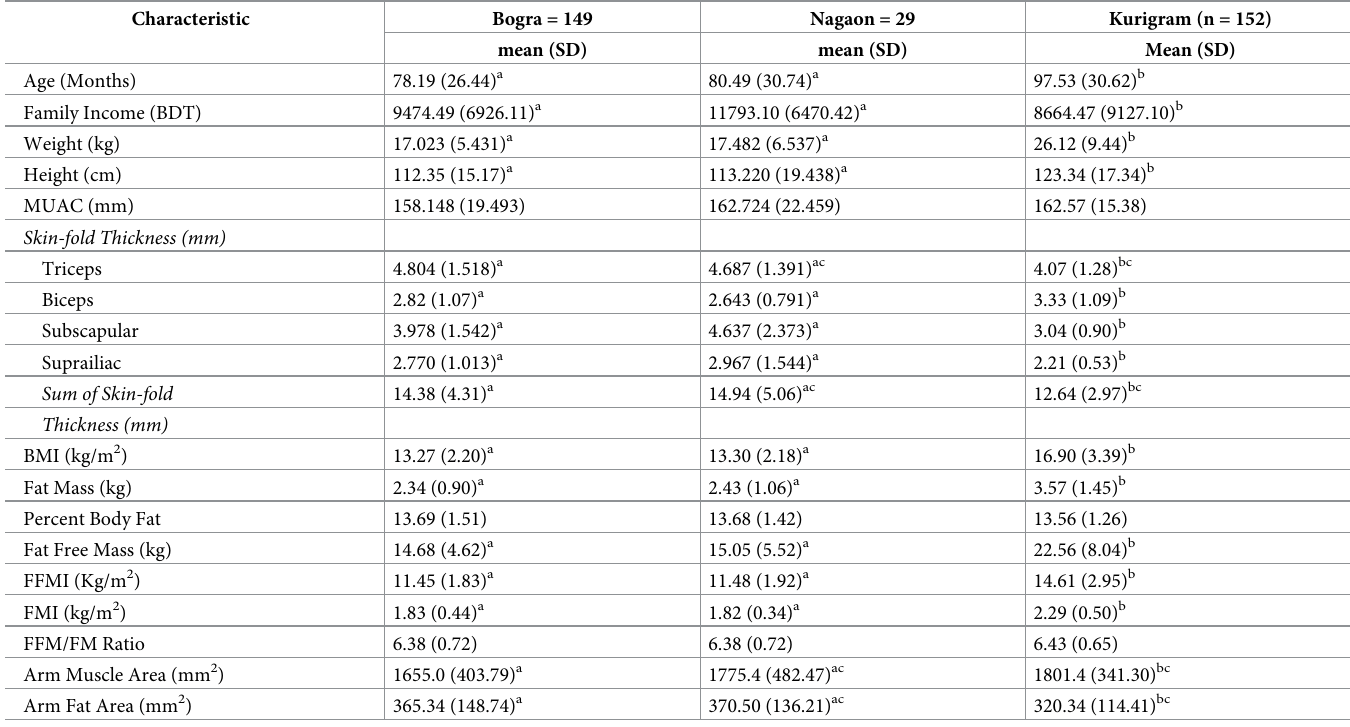
Table 2. Dwelling-specific distributions and comparison of children characteristics (n = 330).